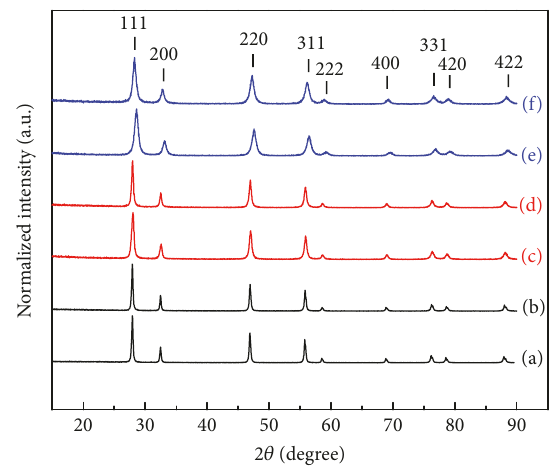
Figure 2: Comparison of XRD patterns of the Pd-impregnated ceria catalysts prepared by using ceria support derived from different metal complex precursors and impregnating Pd with two different concentrations: (a) 1Pd-CeO2-T-Cl, (b) 3Pd-CeO2-T-Cl, (c) 1Pd- CeO2-B-N. Figure 3. According to the overview of SEM images, the Pd- impregnated ceria materials are observed as aggregation